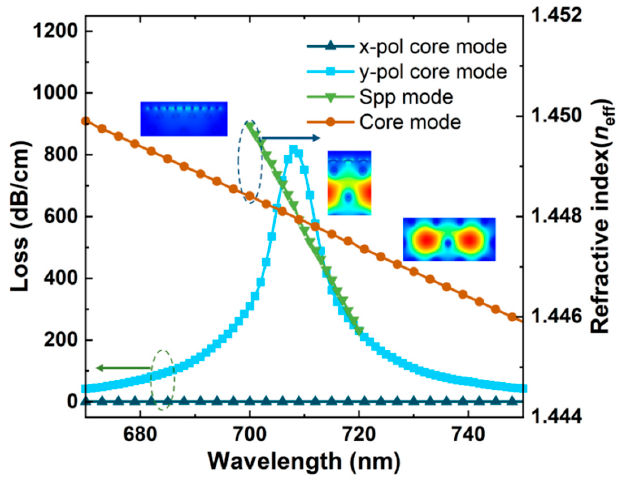
Figure 3. Dispersion relations of the fundamental fiber core mode and Spp mode at analyte n e = 1.33.